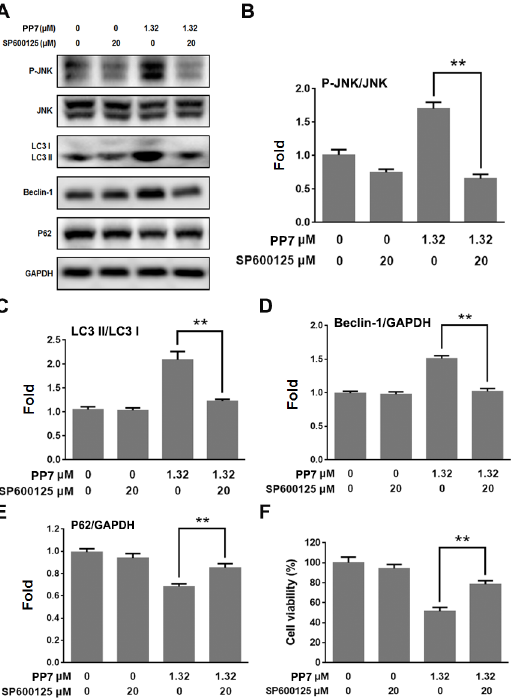
Fig 5. The role of JNK in PP7-triggered autophagy in HepG2 cells. (A) HepG2 cells were incubated in 1.32 μ M PP7 for 24 h with or without pretreatment of JNK inhibitor SP600125 (20 μ M, 1 h). The protein levels of P-JNK, JNK, P62, Beclin-1 and LC3II was detected by Western blot. (B), (C), (D) and (E) were densitometic analysis of (A) from three experiments. MTT assay was used to evaluate the viability of HepG2 cells treated by 1.32 μ M PP7 for 24 h with or without pretreatment of 20 μ M SP600125 for 1 h (F). Values represent the mean ± SD of at least three independent experiments. ** P < 0.01, compared to PP7-treated alone